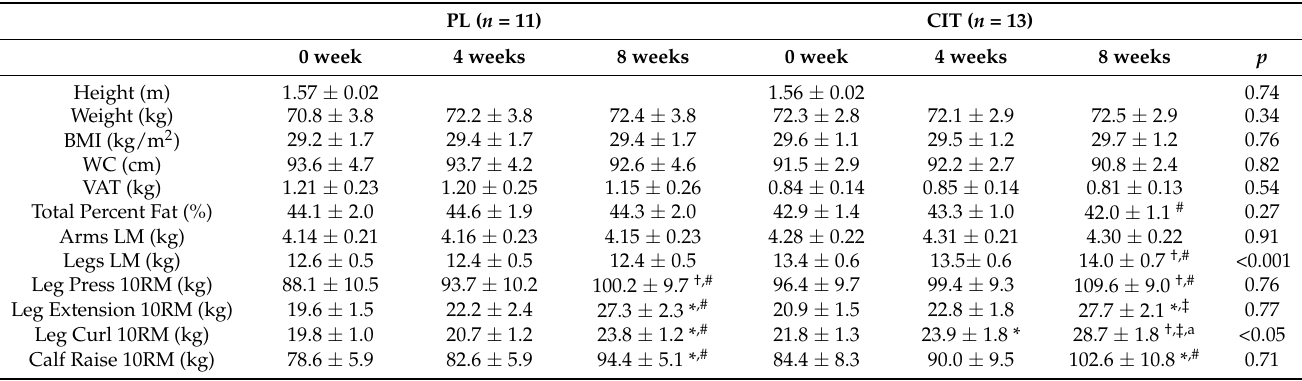
Values are mean ± SE. Abbreviations: PL, placebo; CIT, Citrulline; BMI, body mass index; WC, waist circumference; VAT, visceral adipose tissue; LM, lean mass; RM, repetition maximum. p -values in column are group-by-time